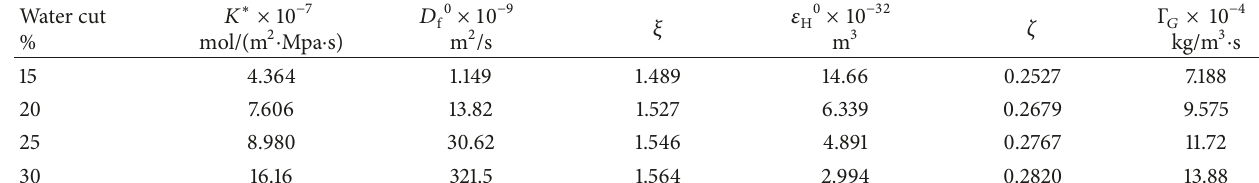
Table 3: Hydrate growth parameters of different water cuts and gas consumed rate.